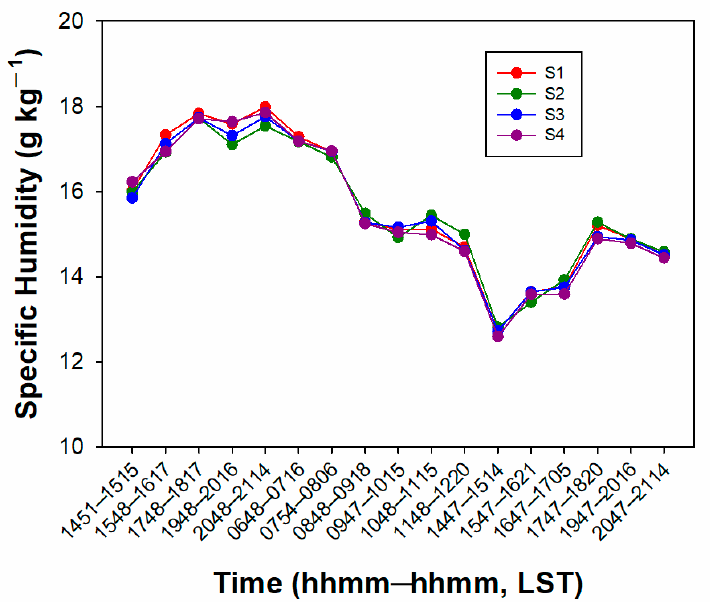
Figure 12. The same as in Figure 10, except for specific humidity.